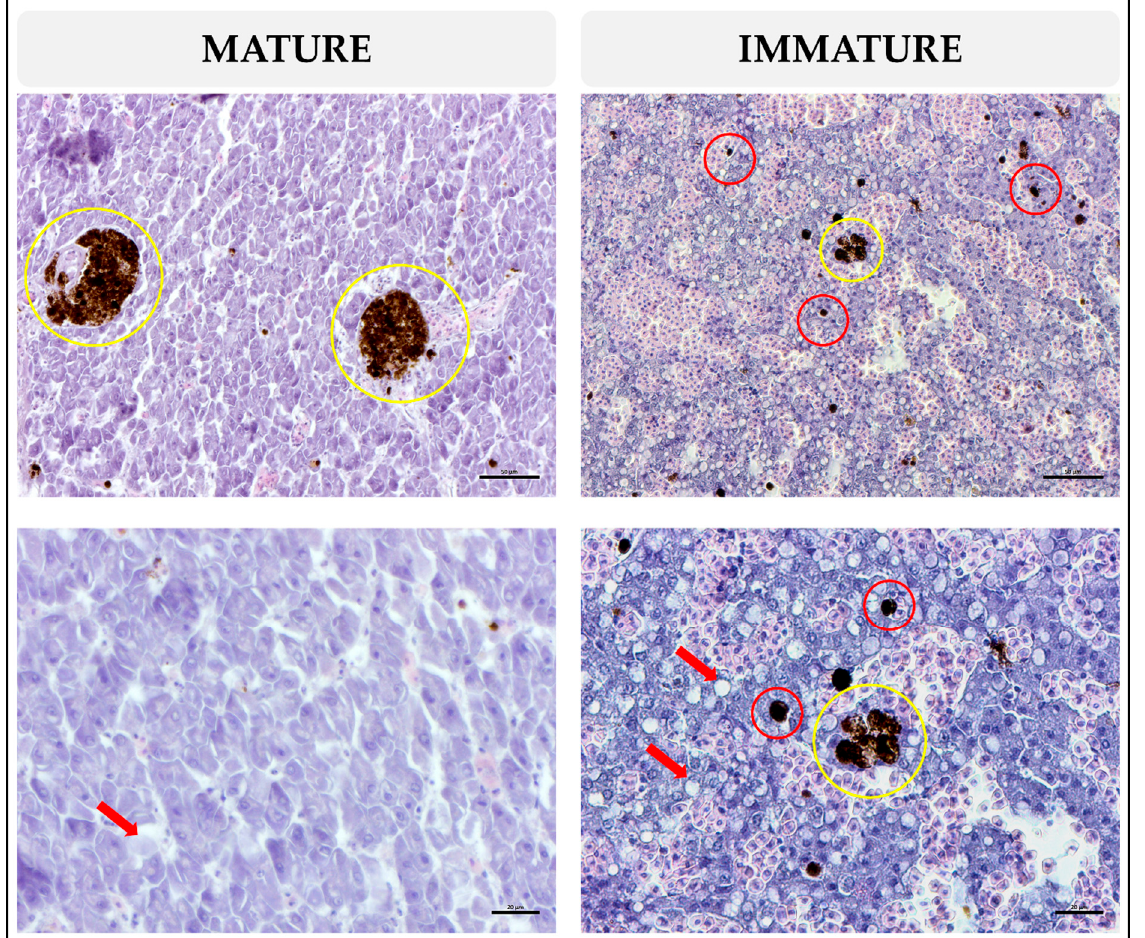
Figure 9. Photomicrograph of the immature and mature liver of Xiphias gladius . Hematoxylin and eosin (H&E) staining of a section of the liver shows lipid components (red arrow); melanomacrophage center presence (yellow circle); single melanomacrophages (red circles).